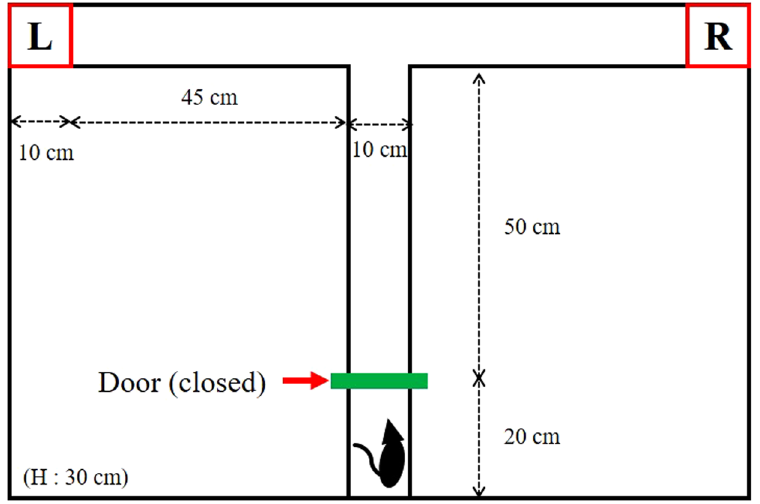
Figure 2. Design of the